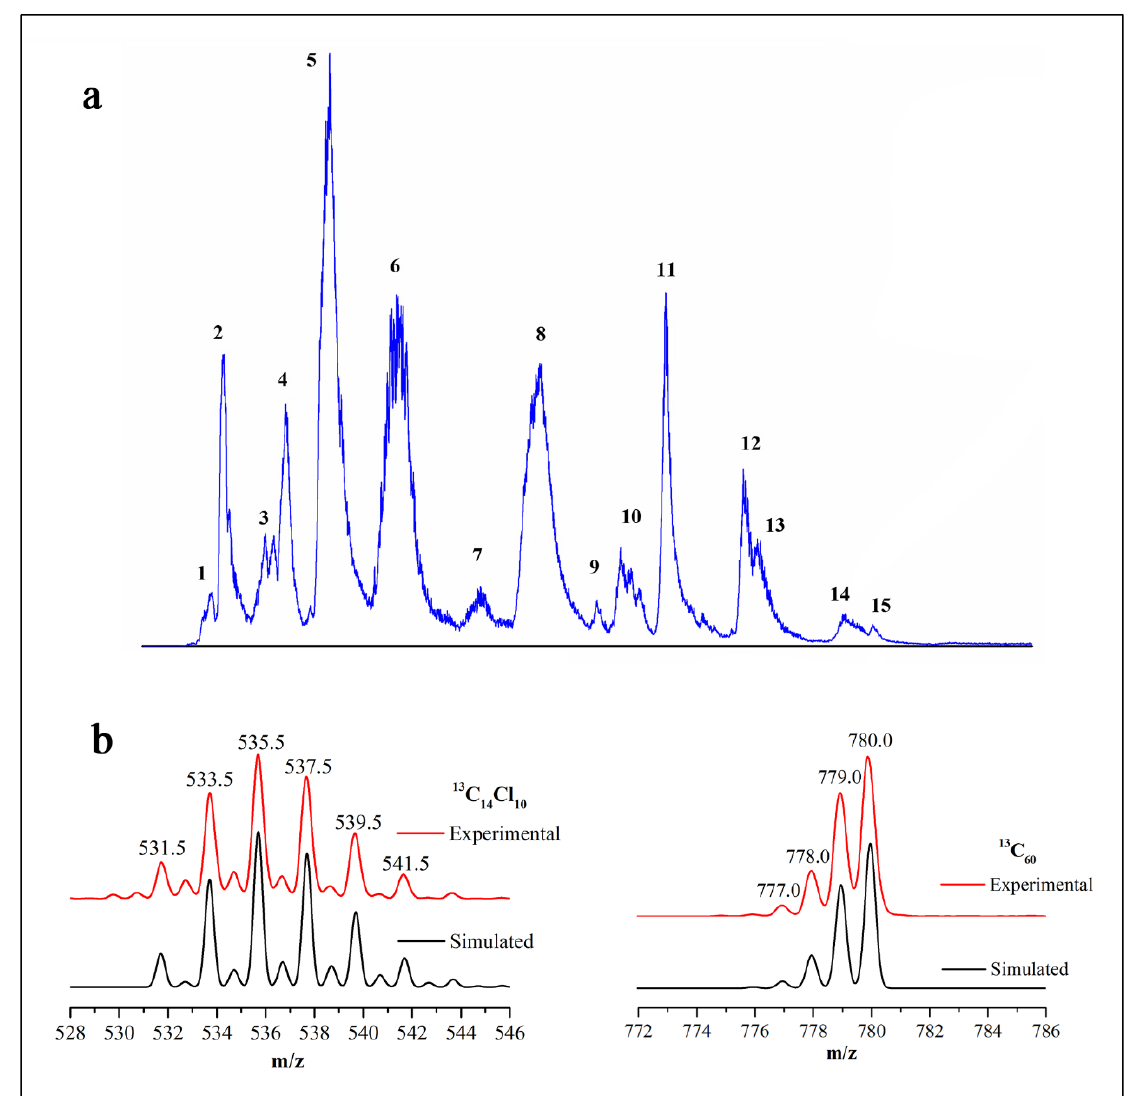
Figure 4. ( a ) HPLC-MS chromatogram of soot products from the pyrolysis of 13 CHCl 3 at 1740 °C. Peaks are labeled by numbers, and their molecular formulae are suggested from their isotope distributions in mass spectra: (1) 13 C 10 Cl 8 ; (2) 13 C 6 Cl 5 O; (3) 13 C 12 Cl 9 O; (4) 13 C 12 Cl 8 ; (5) 13 C 10 Cl 7 O; (6) 13 C 14 Cl 10 ; (7) impurity; (8) 13 C 12 Cl 8 ; (9) 13 C 14 Cl 9 O; (10) 13 C 18 Cl 12 ; (11) 13 C 16 Cl 10 ; (12) 13 C 18 Cl 10 ; (13) 13 C 22 Cl 12 ; (14) 13 C 24 Cl 12 ; and (15) 13 C 60. ( b ) The experimental and theoretically simulated mass spectra of 13 C 14 Cl 10 and 13 C 60 ( 13 C = 99%).